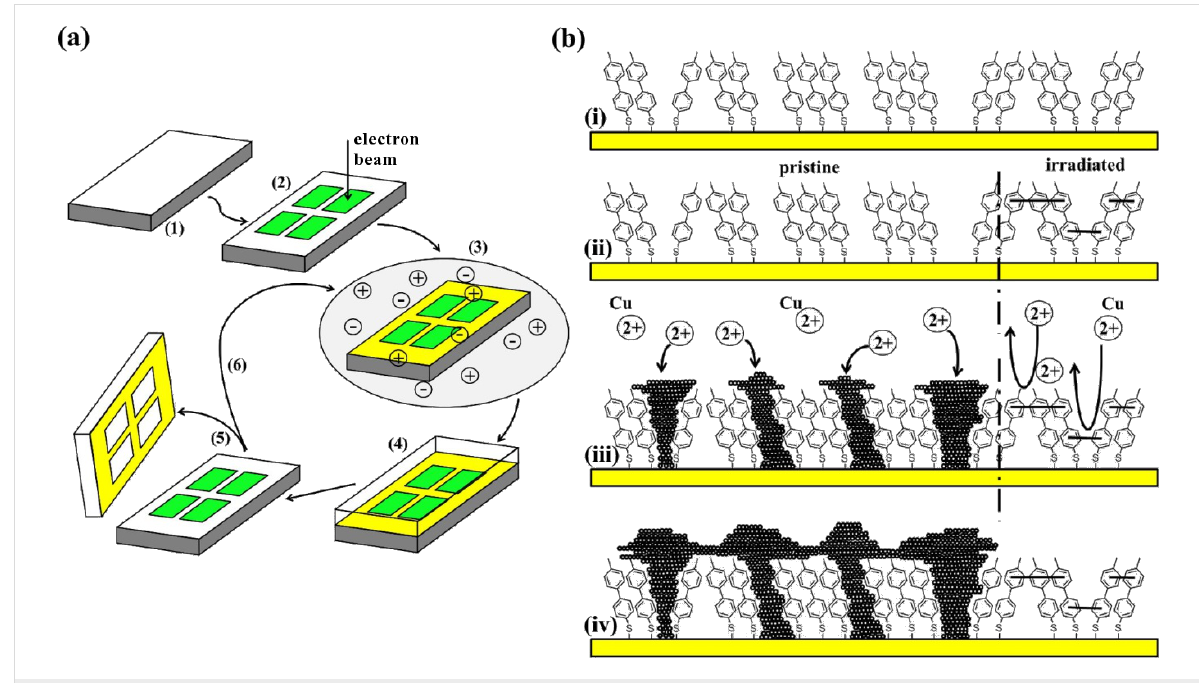
Figure 1: (a) Scheme of SAM controlled electrodeposition and lift-off of metal structures. Starting from a uniform SAM of MBP0 (1), patterning is accomplished by e-beam lithography (2). Acting as a negative resist, electrochemical metal deposition (3) selectively occurs only in the nonirradiated areas. The low surface energy of the CH 3 terminated SAM enables the transfer of the metal pattern to an insulating substrate (4,5) and reuse of the master pattern (6). (b) Illustration of patterning and deposition processes on the molecular scale. When a pristine aromatic SAM (i) is irradiated by an e-beam, cross-linking of molecules results in bridging of defects (right of ii). The resulting passivation confines the deposition to areas of the native SAM (iii). Metal nucleation starts at the bottom of the SAM and deposits grow in a mushroom-type fashion until they coalesce to form a film